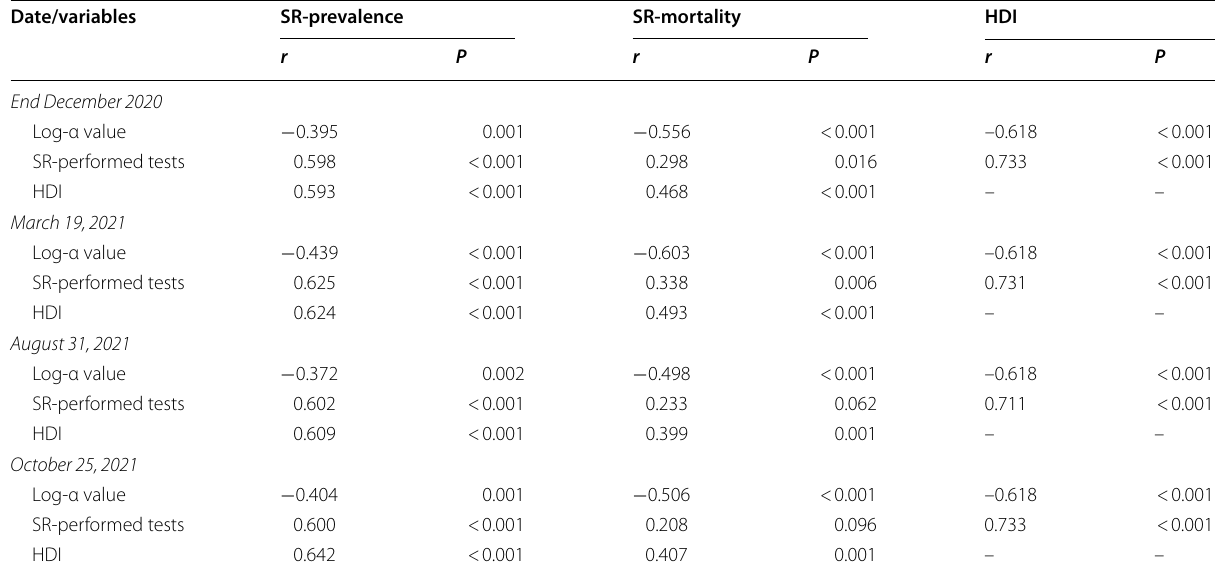
df is 63 for all comparisons. SR and Log mean square root- and logarithmic-transformed variables